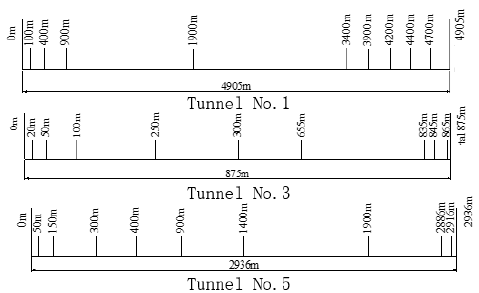
Figure 2. Layout of the test section.